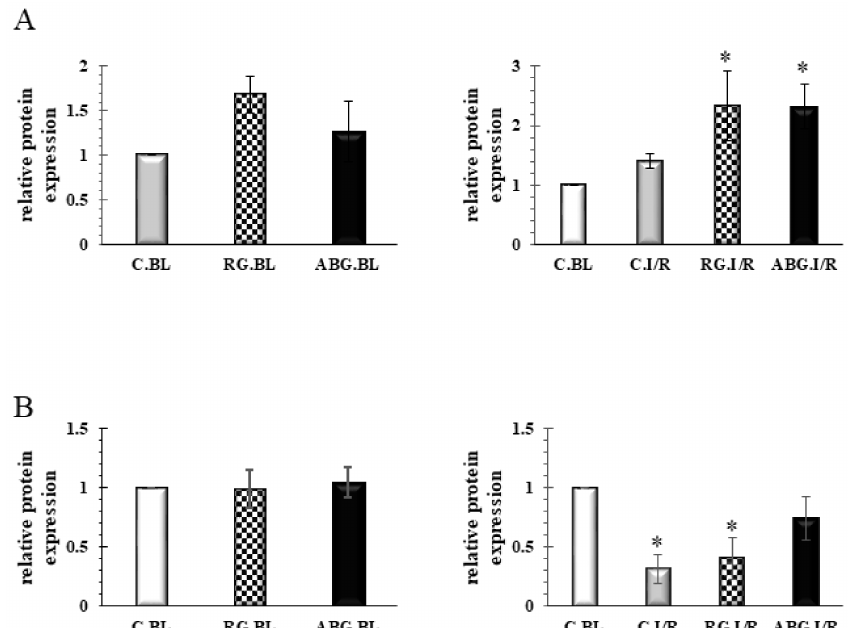
Figure 5. Effect of raw and aged black garlic on HO-1 and iNOS expression. Panel ( A ): Protein samples from hearts originating from animals treated with RG, ABG or vehicle were separated, blotted and probed with the HO-1 antibody. Panel ( B ): Protein samples from hearts originating from animals treated with RG, ABG or vehicle were separated, blotted and probed with iNOS antibody. Results are expressed as mean ± SEM n = 5–7. Raw garlic (RG); aged black garlic (ABG). BL: baseline samples; I/R: ischemia/reperfused samples. * p < 0.05 in comparison with the control baseline parameters